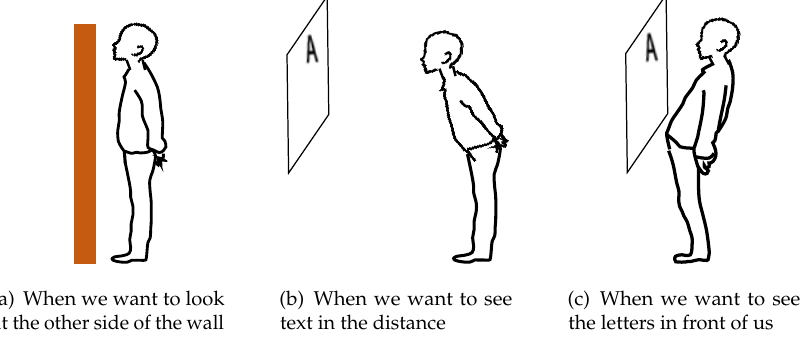
Figure 3. Motion in daily